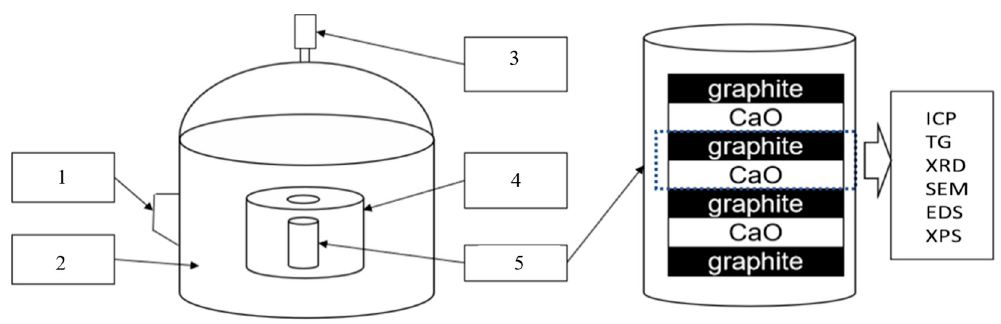
Figure 2. Schematic set-up for microwave heating. 1: microwave source, 2: microwave cavity, 3: infrared thermometer, 4: insulation barrel, 5: crucible.